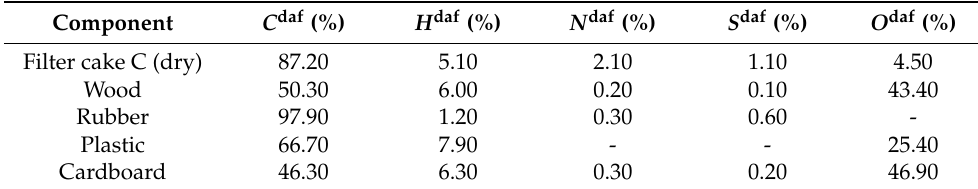
Table 2. Ultimate analysis of composite liquid fuel components